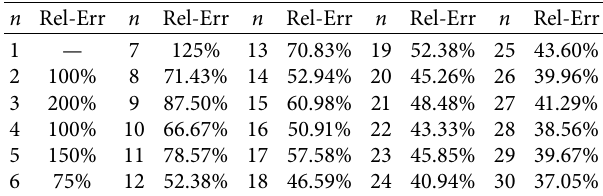
( n ) + 1/2 􏽪 􏽫 to h ( n ) when n ≤ 30. g